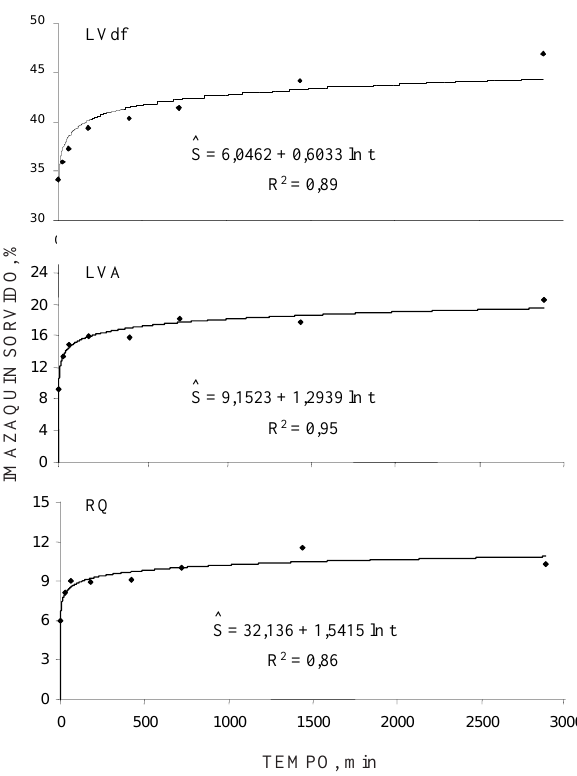
Figura 3. Modelo de Elovich aplicado aos dados de cinética de sorção de imazaquin em Latossolo Vermelho distroférrico (LVdf), Latossolo Ver- melho-Amarelo (LVA) e Neossolo Quartzarênico